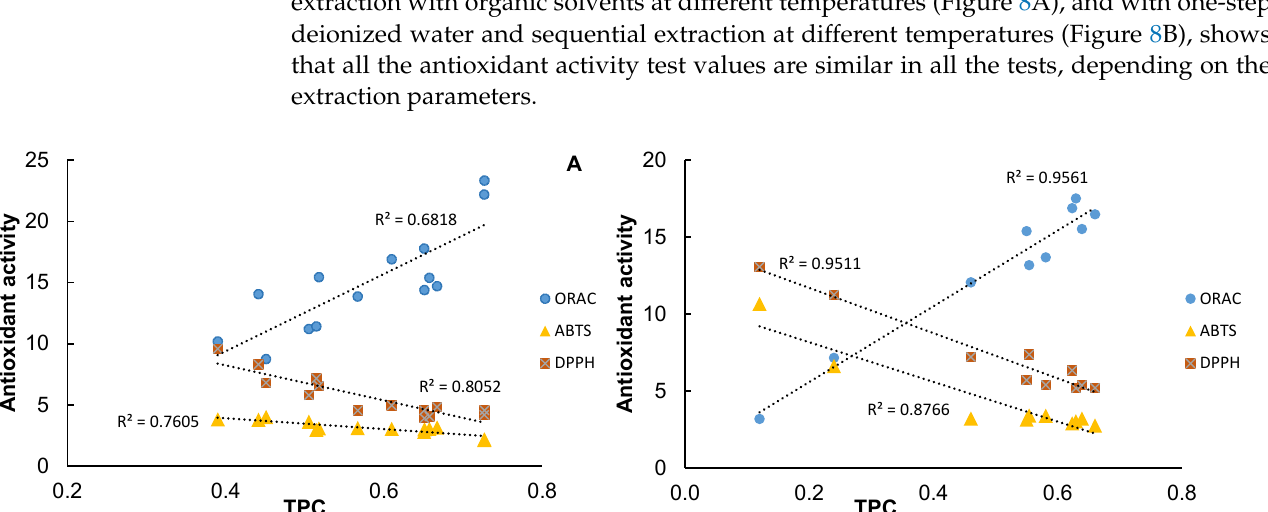
Figure 8. Correlations between antioxidant activity tests and total polyphenol content. ( A ) Sequential extraction with organic solvents at different temperatures ( B ) with one-step and sequential extraction with deionized water at different temperatures.